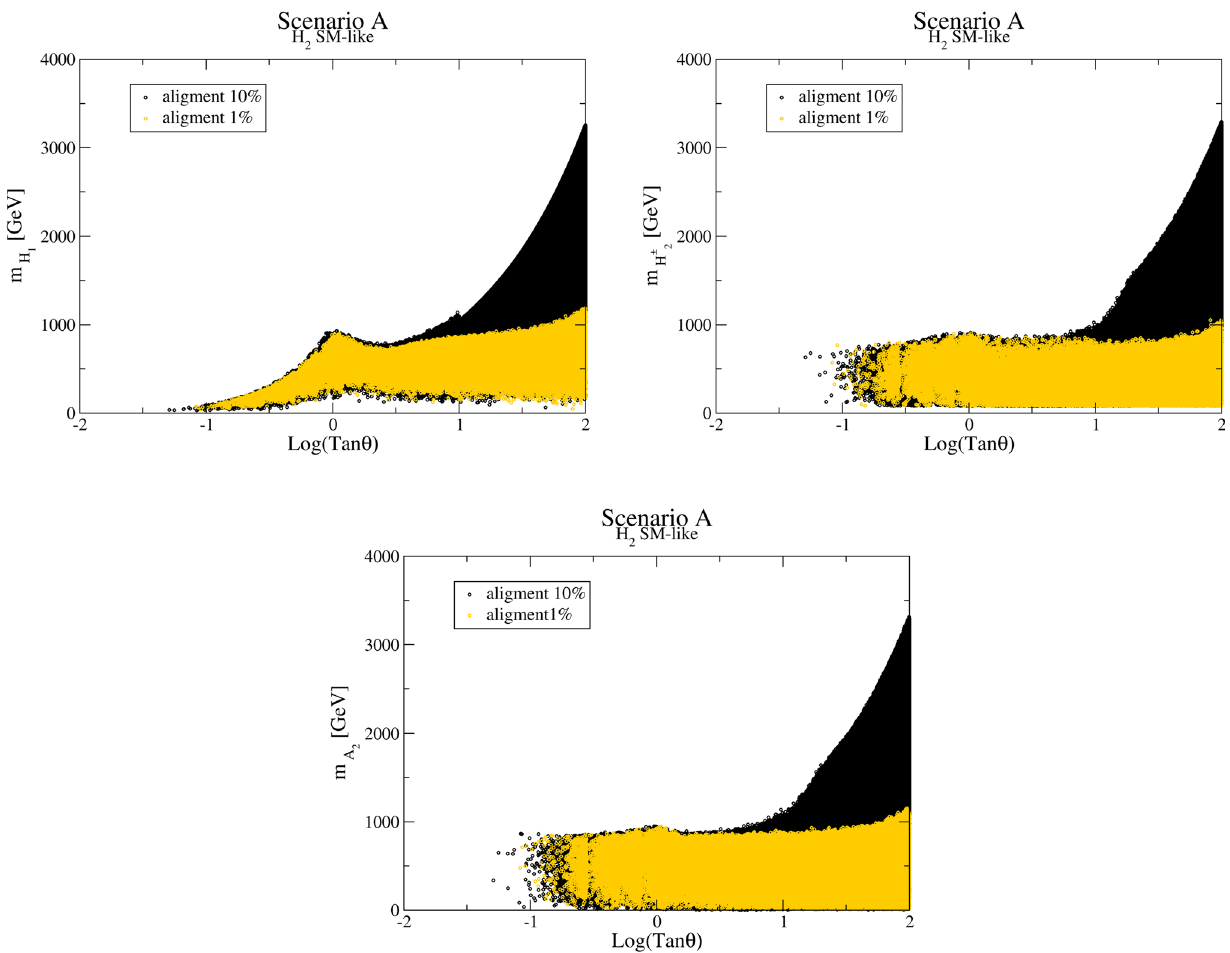
Fig. 2 Dependence of the masses m H (yellow points) on (α − θ) . The points shown comply with the unitarity and stability conditions, and the restriction of m H